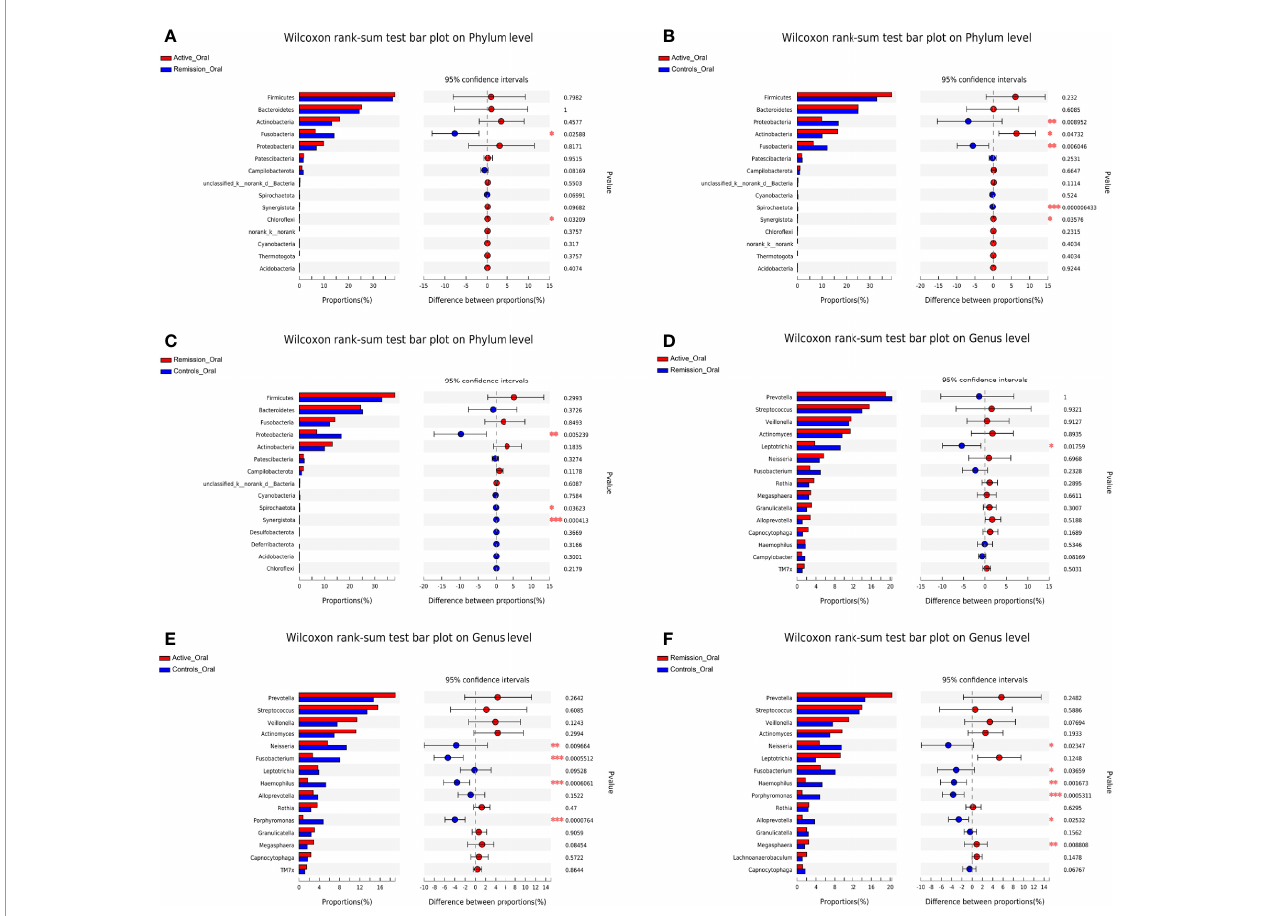
FIGURE 4 | Inter-group difference analysis of microbiota in the oral cavity of patients with CD and healthy controls. (A – C) Wilcoxon rank-sum test bar plot of different taxa on the phylum level. (D – F) Wilcoxon rank-sum test bar plot of different taxa on the genus level. *, **, and *** correspond to p-values <0.05, 0.01, and 0.001,